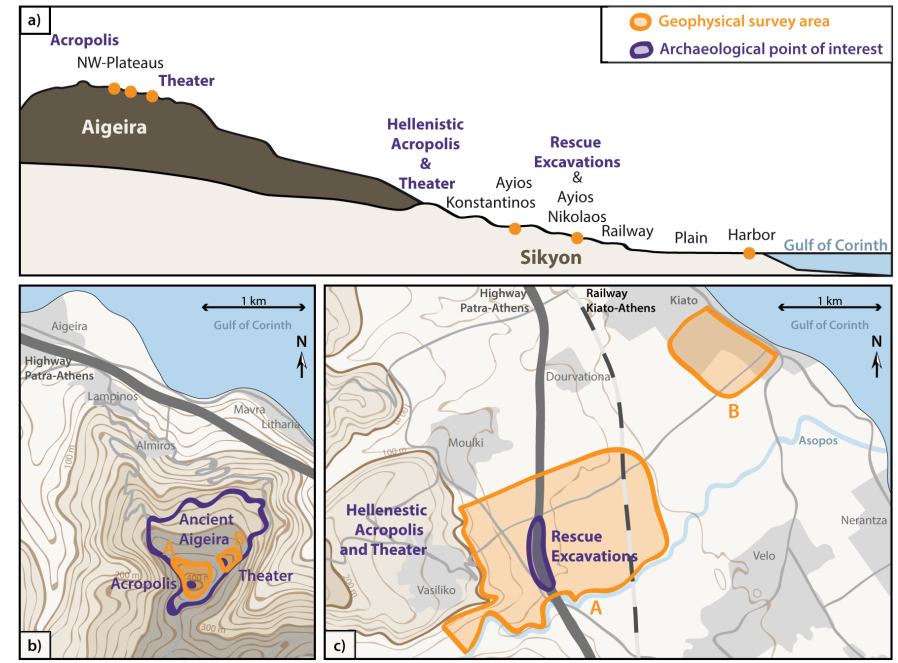
Figure 1. ( a ) Schematic topographic section. Marked are also the location of the exemplary cases presented in this article. ( b ) Overview of the location of Aigeira and the two main survey areas near the acropolis (A) and the area around the theater (B). ( c ) Overview of Sikyon with the two survey areas of the main settlement (A) and the harbor